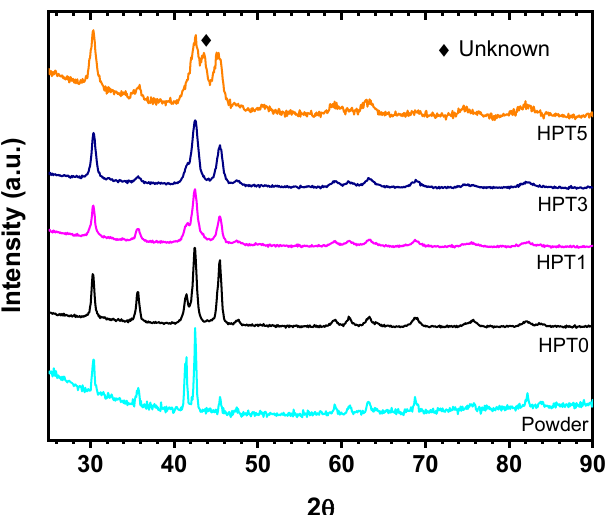
Figure 1. X-ray diffraction patterns of LaNi 5 at various stages: as-received powder (Powder), pressed pellet (HPT0) and pellet after 1, 3 and 5 HPT turns (HPT1, HPT3 and HPT5). The vertical lines indicate the position of LaNi 5 Bragg peaks.